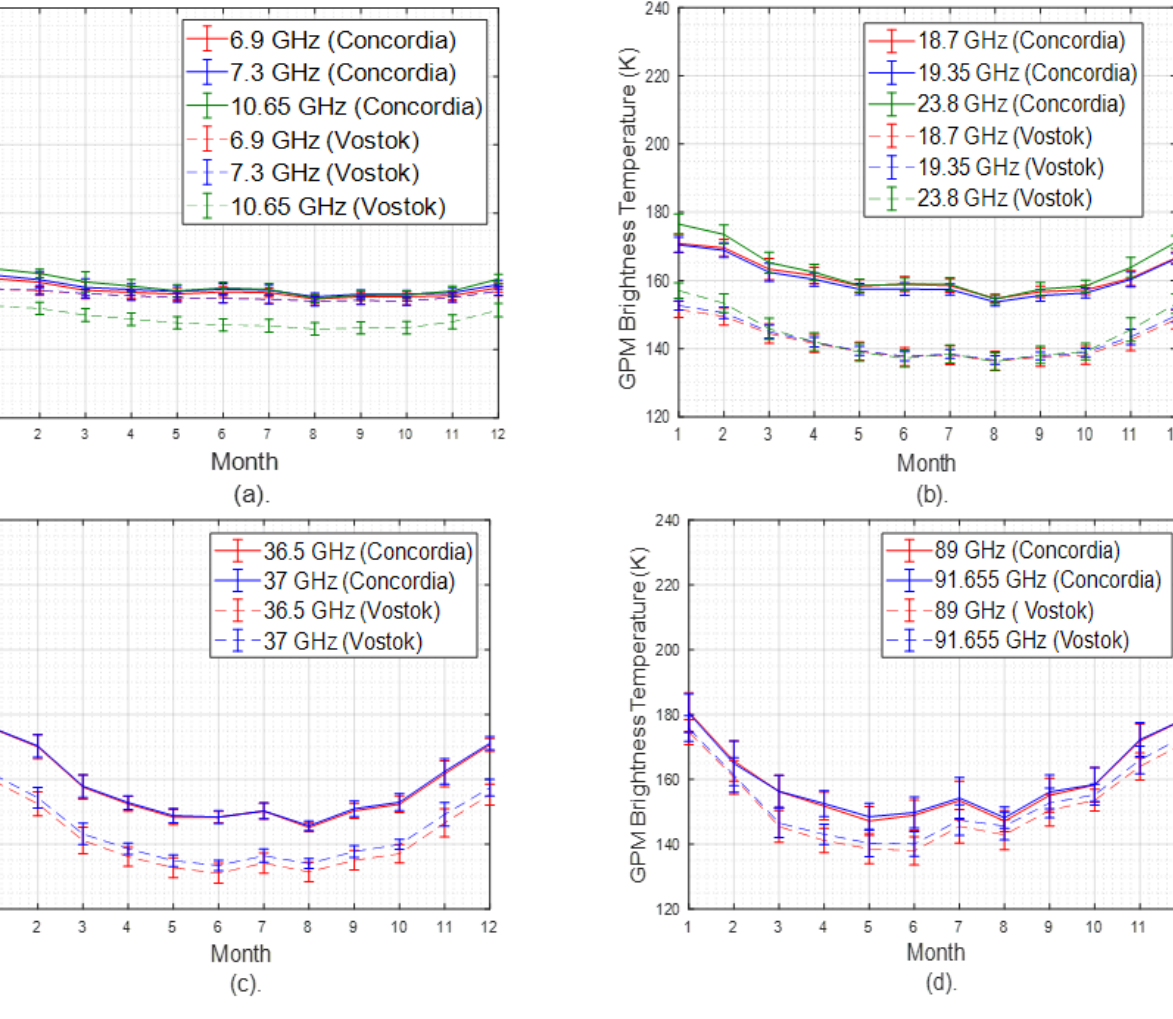
Figure 9. Horizontally polarized brightness temperatures measured by AMSR2 and SSMIS over (solid) Concordia and (dashed) Vostok Stations in Antarctica versus month between 2020 and 2021 at frequencies ( a ) 6.9 GHz, 7.3 GHz, and 10.65 GHz; ( b ) 18.7 GHz, 19.35 GHz, and 23.8 GHz; ( c ) 36.5 GHz and 37 GHz; and ( d ) 89 GHz and 91.65 GHz. The vertical lines demonstrate the ranges of ±1 monthly standard deviations. Note that all measurements except those from the 6.9 GHz and 7.3 GHz channels of AMSR2 are intercalibrated and the brightness temperatures were averaged over month and 0.25° × 0.25° grids.